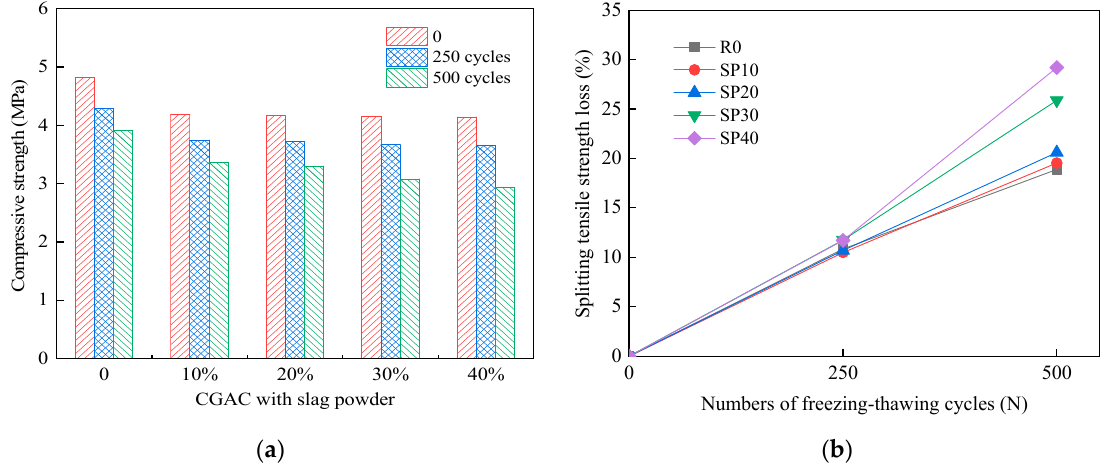
Figure 10. ( a ) Compressive strength and ( b ) compressive strength loss of CGAC with different slag powder content after F-T cycles.